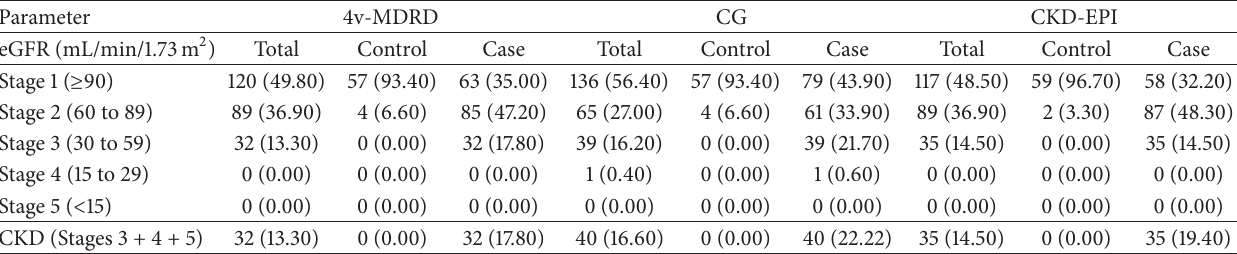
Table 5: Estimates of the prevalence of CKD in the study population using the renal function equations.